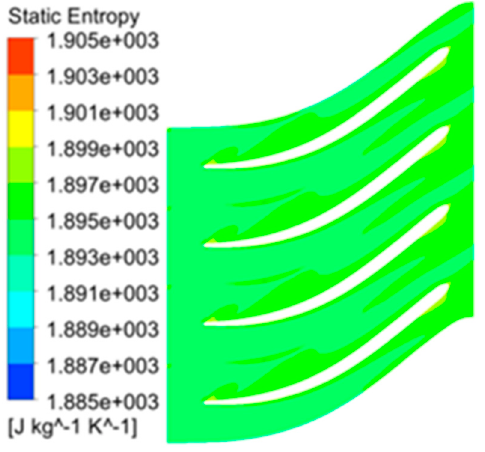
Figure 16. Static entropy distribution of traditional impeller.